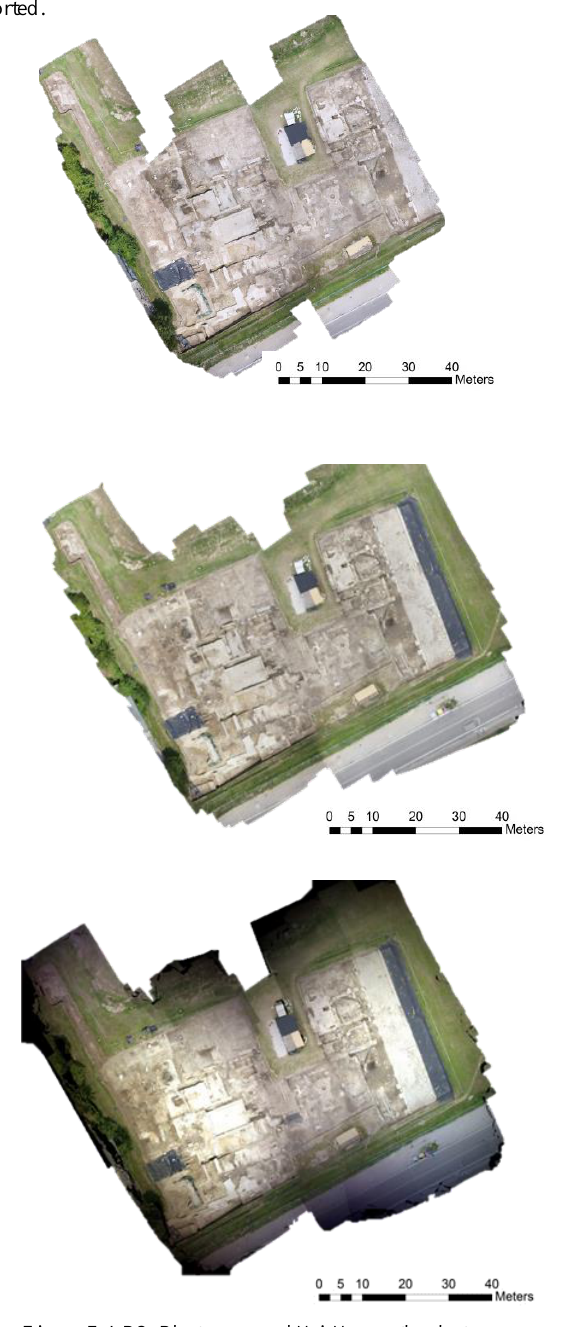
Figure 7. LPS, Photoscan and MicMac orthophoto.